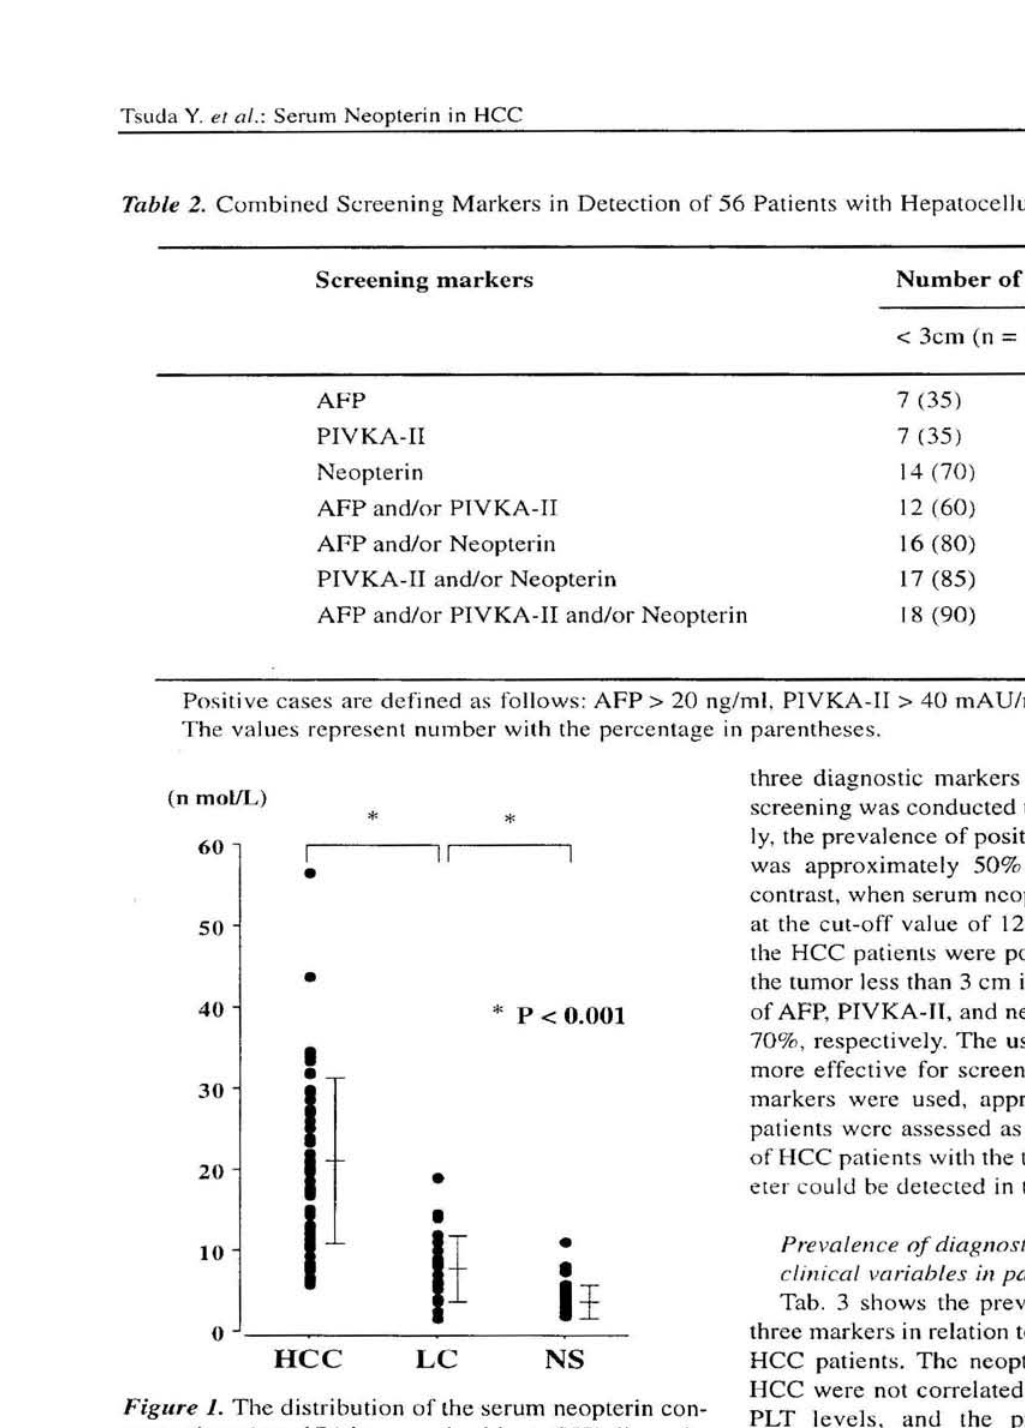
Figure 1. The distribution of the serum neopterin con- centrations (nmol/L) in normal subjects (NS), liver cir- rhosis (LC), and hepatocellular Carcinoma (HCC) patients. The mean serum neopterin level of HCC patients was significantly higher than that of LC patients (P <0.001), which was significantly higher than that of normal subjects (P